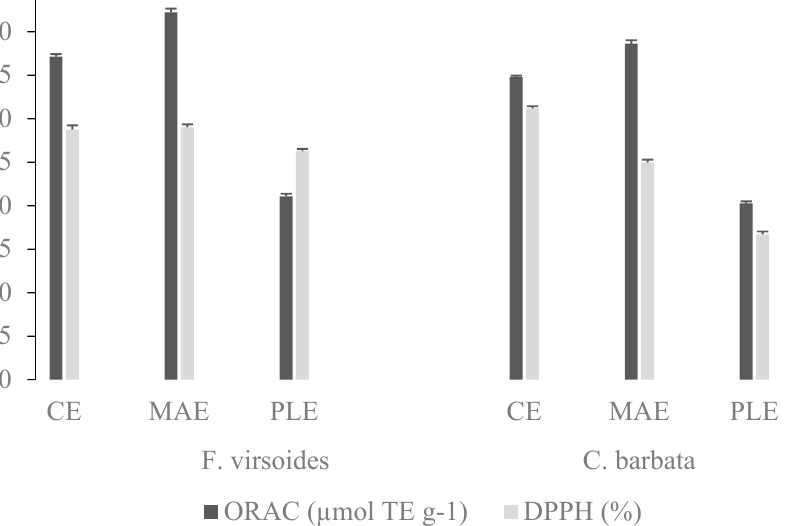
Figure 1. Antioxidant capacity of F. virsoides and C. barbata polysaccharides, obtained by conventional extraction (CE), microwave assisted extraction (MAE), and pressurized liquid extraction (PLE), determined by oxygen radical absorbance capacity (ORAC) and DPPH assays.